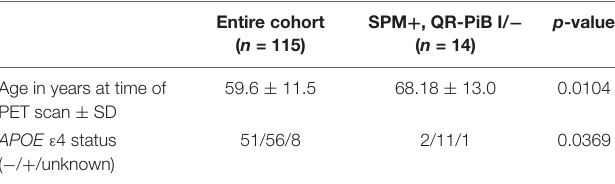
TABLE 5 | Entire test cohort vs. statistical parametric mapping (SPM) positive, QR-PiB indeterminate/negative.